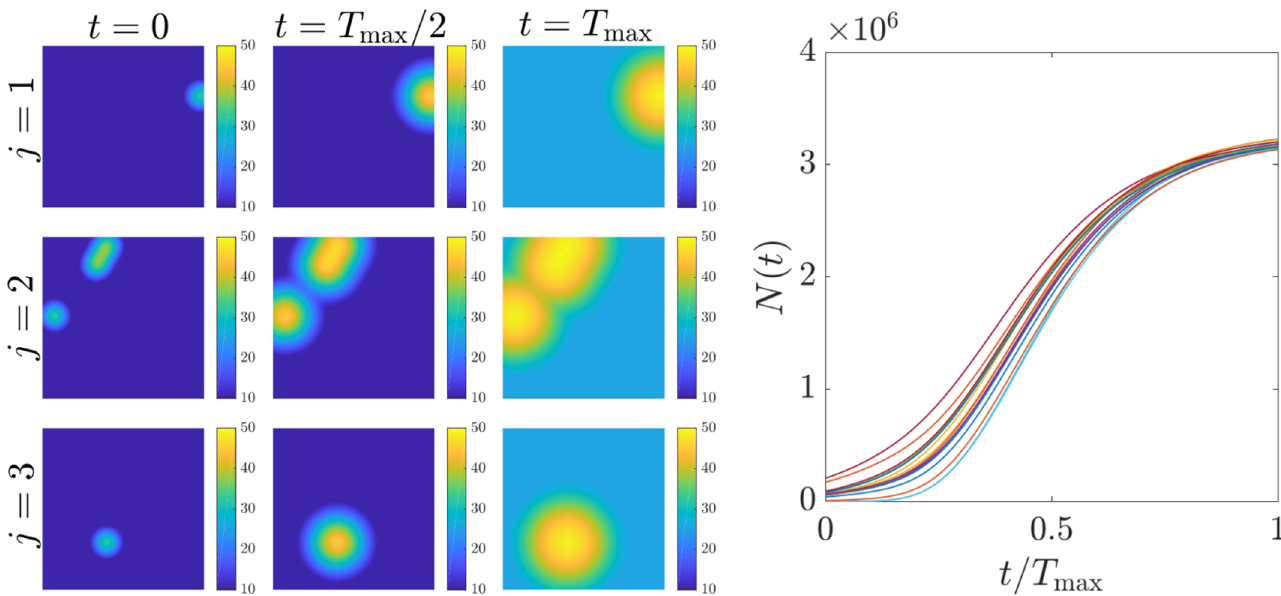
Fig 4. Tumor growth under uncertainty. A simulation of Gompertzian growth of the spatial random field n ( r , t ), as modeled in Eq (9) with c ( r , t ) (cid:17) 0, is displayed on the left. In this simulation, both the local growth constant μ ( r ) and the local carrying capacity n max ( r ) are spatially constant but random; the initial condition n ( r , 0) is taken as a so-called lumpy background random process (see S2 Appendix). Three realizations (rows) are shown at three times. The total cell number N ( t )as defined in (6) is shown on the right for 16 realizations of the process.